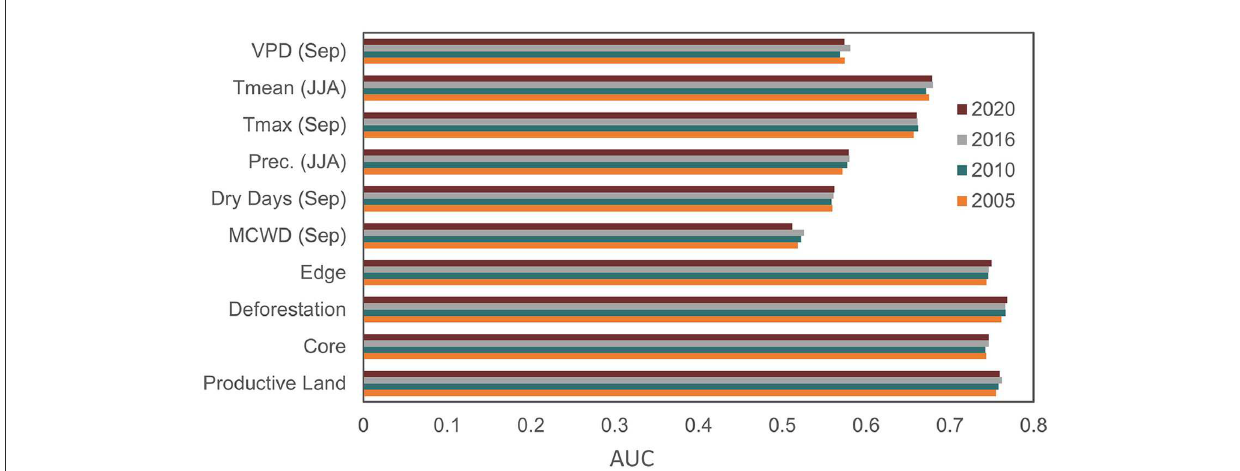
FIGURE4 Relative importance based on the AUC test of each predictive variable for the fire probability models in 2005, 2010, 2016, and 2020. “Productive Land”: percentage of productive areas, “Core”: core area, “Deforestation”: annual percentage of deforested area, “Edge”: forest edge area, “MCWD (Sep)”: MCWD index for the month of September, “Dry Days (Sep)”: number of consecutive days with precipitation below 1mm of September, “Prec. (JJA)”: total precipitation of June, July, and August, “Tmax (Sep)”: maximum temperature of September, “Tmed (JJA)”: average temperature of June, July, and August, “VPD (Sep)”: vapor pressure deficit of September.